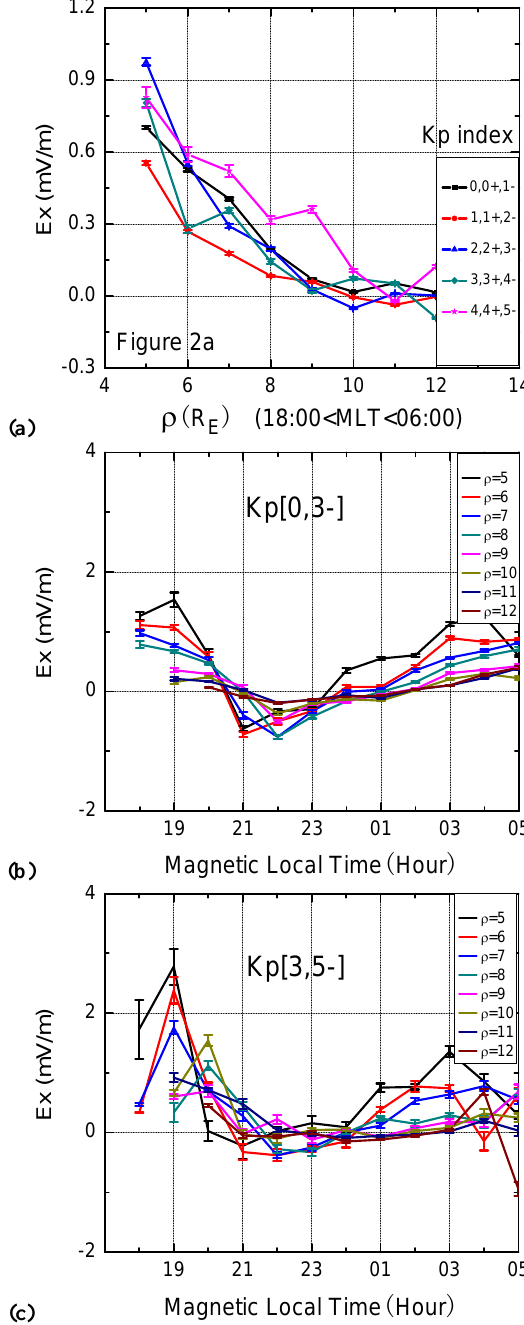
Figure 2. (a) The variation of the Ex component of the electric field as a function of ρ value and geomagnetic activity Kp index. (b)The variation of the Ex component of the electric field as a function of magnetic local time for geomagnetic activity Kp less than 3. (c) The variation of the Ex component of the electric field as a function of magnetic local time for geomagnetic activity Kp between 3 and 5-.